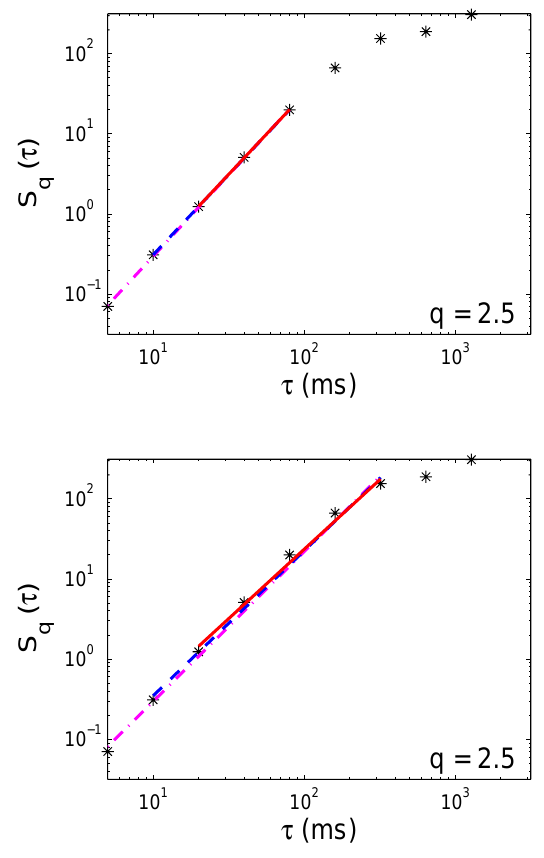
Fig. 3. Linear fitting of the log-log plot of S q (τ) vs. τ at q = 2 . 5 based on subsets of data points that correspond to the following time scales: (Top) solid red line: (20, 40 and 80ms); dashed blue line: (10, 20 and 80ms); dot-dashed magenta line: (5, 10 and 80ms). (Bottom) The data point at 320ms is added to the subsets of the top panel, represented by the corresponding line